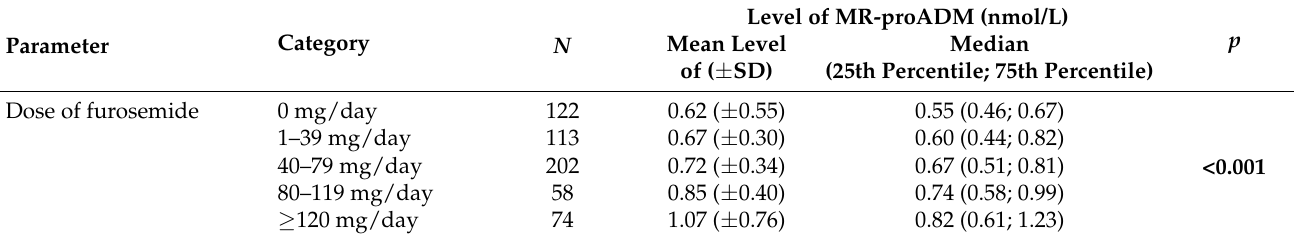
Figure 3. Distribution of MR-proADM level. Table 5. Dose of diuretics according to the level of MR-proADM.